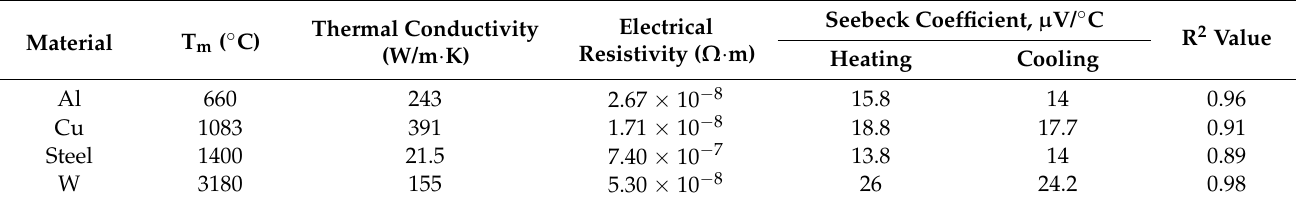
Figure 3. Voltage-temperature plots for ( a ) PG-Al, ( b ) PG-Cu, ( c ) PG-Steel, and ( d ) PG-W TCs obtained from experimental data upon heating to 500 °C. Table 2. Summary of Seebeck coefficients under heating and cooling cycles in relation to the thermal and electrical properties of the thermoelements